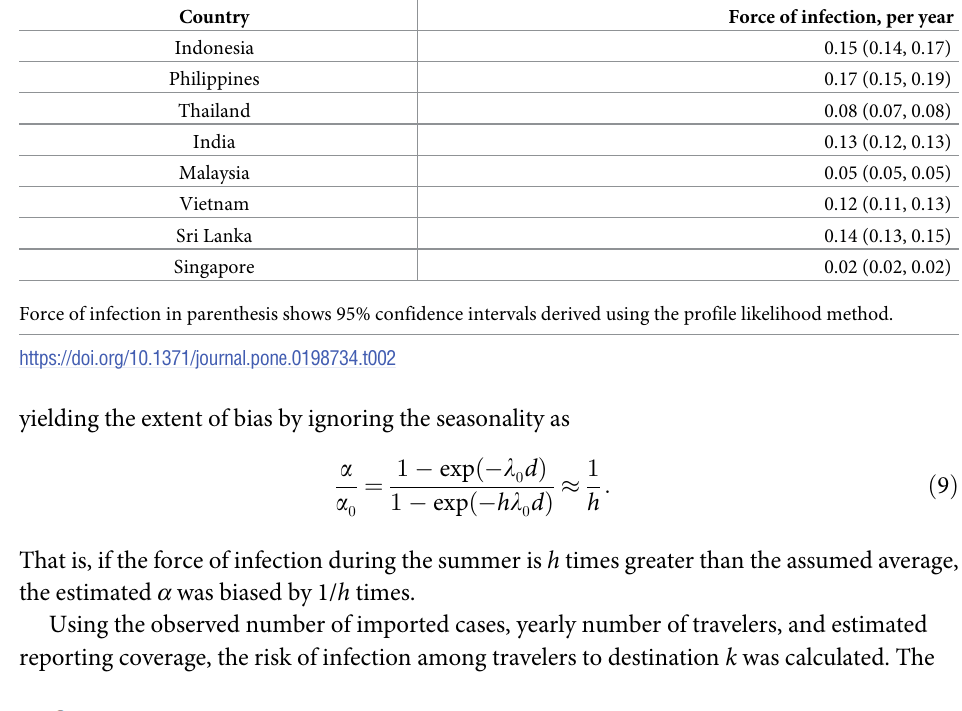
Table 2. Estimated force of infection of dengue virus infection in South and Southeast Asian countries.